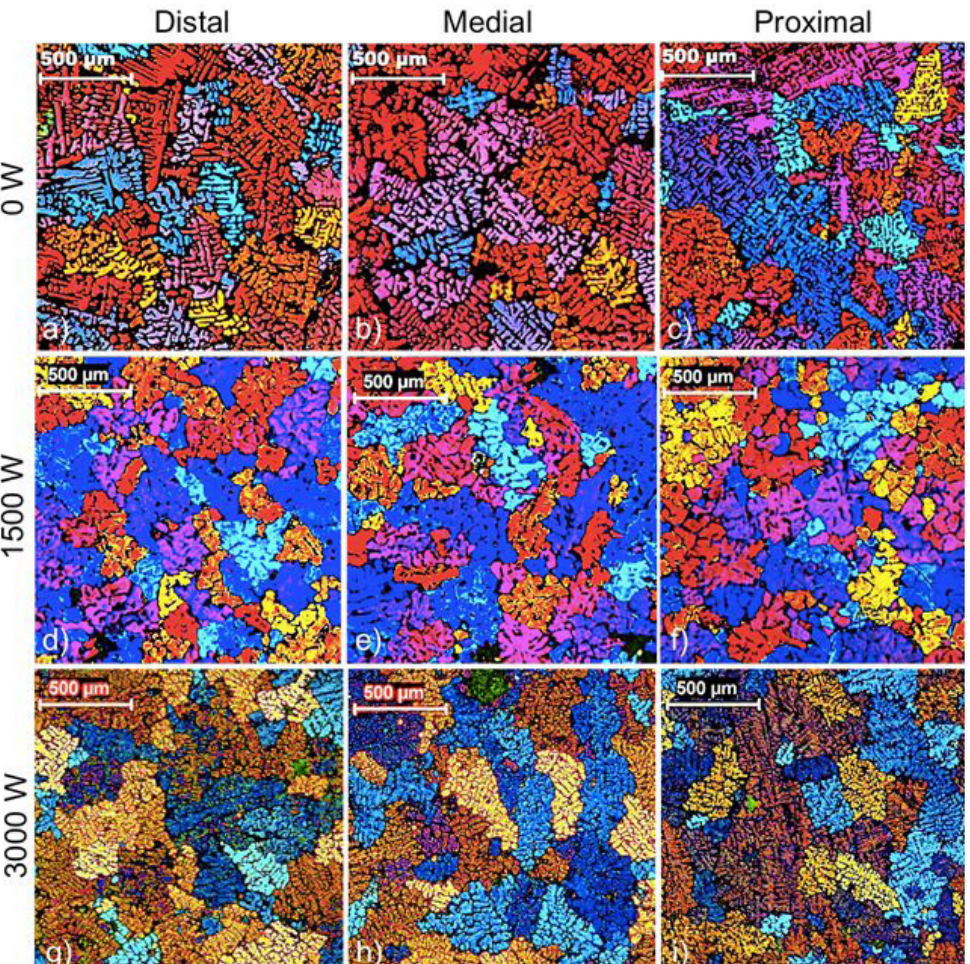
Figure 9. PL microstructure of distal (a, d, g), medial (b, e, h) and proximal (c, f, i) regions of an ingot cast by route 4 with PSC and without EMS (a, b, c) and with PSC and with EMS (1500 W: d, e, f; 3000 W: g, h,